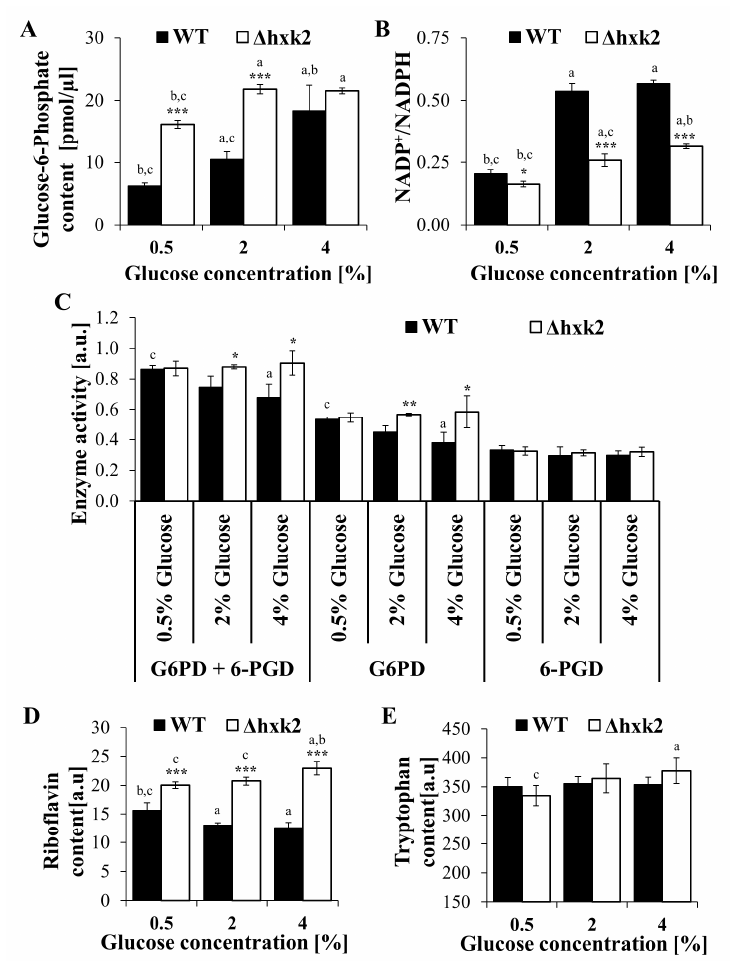
Figure 6. Parameters connected with biosynthetic capabilities and the action of the pentose phosphate pathway in yeast cells cultured in conditions with different glucose concentration. ( A ) The content of glucose-6-phosphate (G6P) determined in deproteinized cell extracts (10 kDa MWCO) using Glucose-6-Phosphate Assay; ( B ) NADP + , and NADPH contents determined with the use of NADP / NADPH-Glo Assay. The results are presented as a NADP + / NADPH ratios; ( C ) pentose phosphate (PP) pathway enzymes activity: glucose-6-phosphate dehydrogenase (G6PD) and 6-phosphogluconate dehydrogenase (6-PGD) determined spectrophotometrically by measuring the rate of NADP + reduction at 340 nm. The data was expressed in arbitrary units as mean ± SD, ( D ) riboflavin content in the cell extracts determined by fluorimetric measurements at λ ex = 460 nm and λ em = 535 nm. The values are expressed in arbitrary units, ( E ) tryptophan content in the cell extracts determined by fluorimetric measurements at λ ex = 290 nm and λ em = 325 nm. The values are expressed in arbitrary units. The results are presented as mean ± SD from three independent experiments. * p < 0.05, ** p < 0.01, *** p < 0.001 as compared to the WT strain; a—different to medium with 0.5% glucose, b—different to medium with 2% glucose, c—different to medium with 4% glucose.